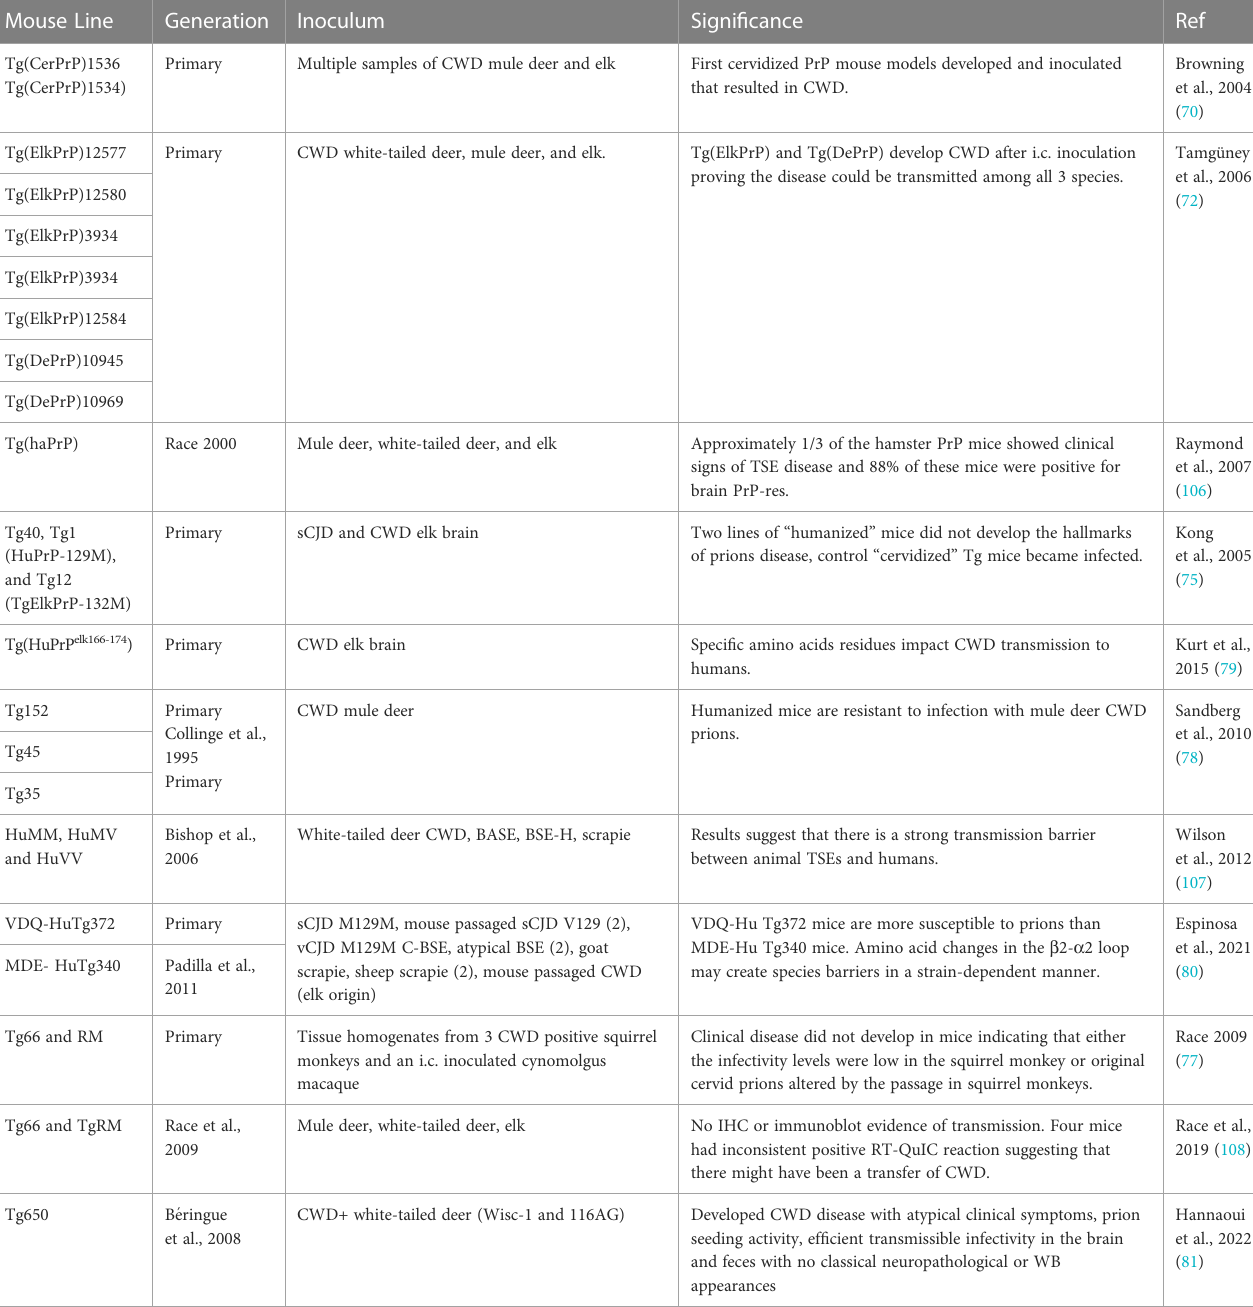
TABLE 9 Investigating transmission in regard to species